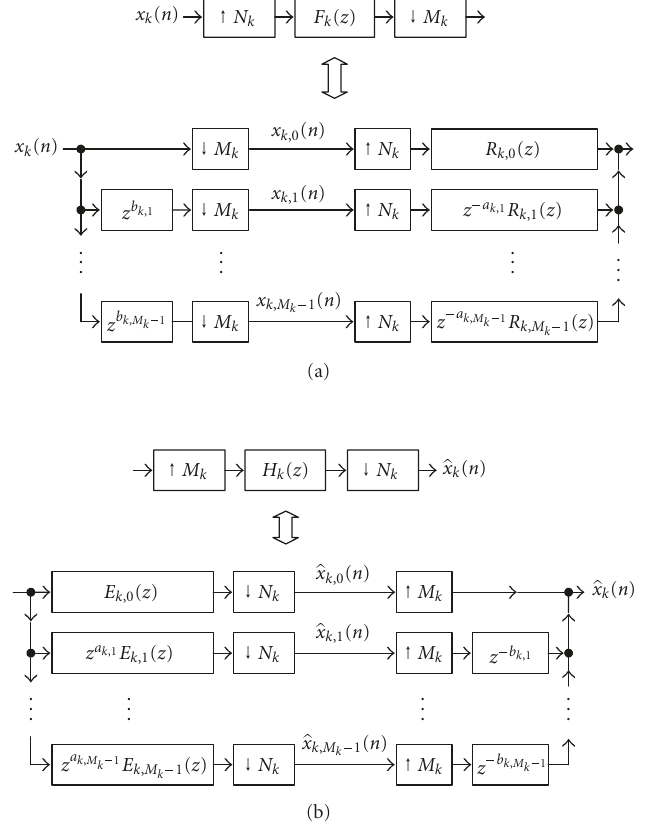
Figure 3: (a) Equivalent circuit of the k th subband in the transmitting bank, (b) equivalent circuit of the k th subband in the receiving bank.